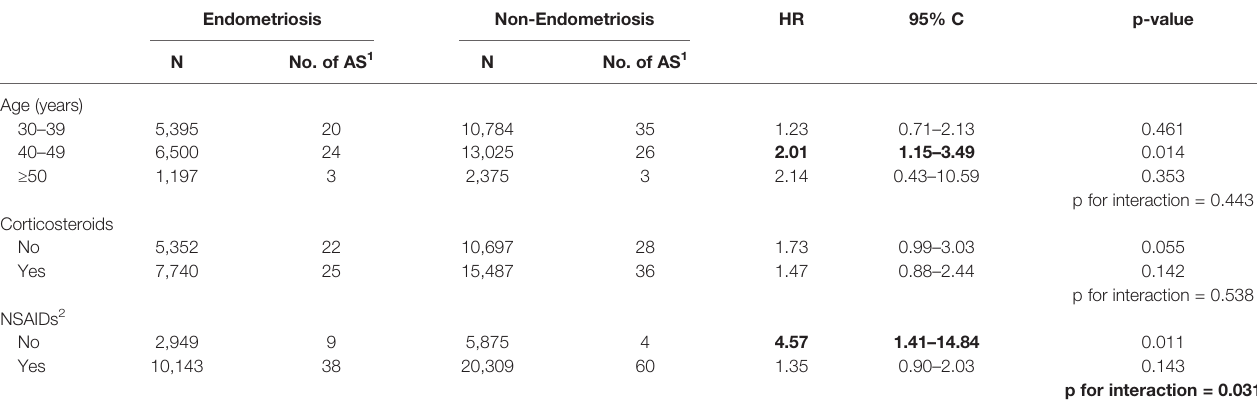
TABLE 3 | Risk assessment of endometriosis or non-endometriosis subjects with age, corticosteroids, or NSAIDs.